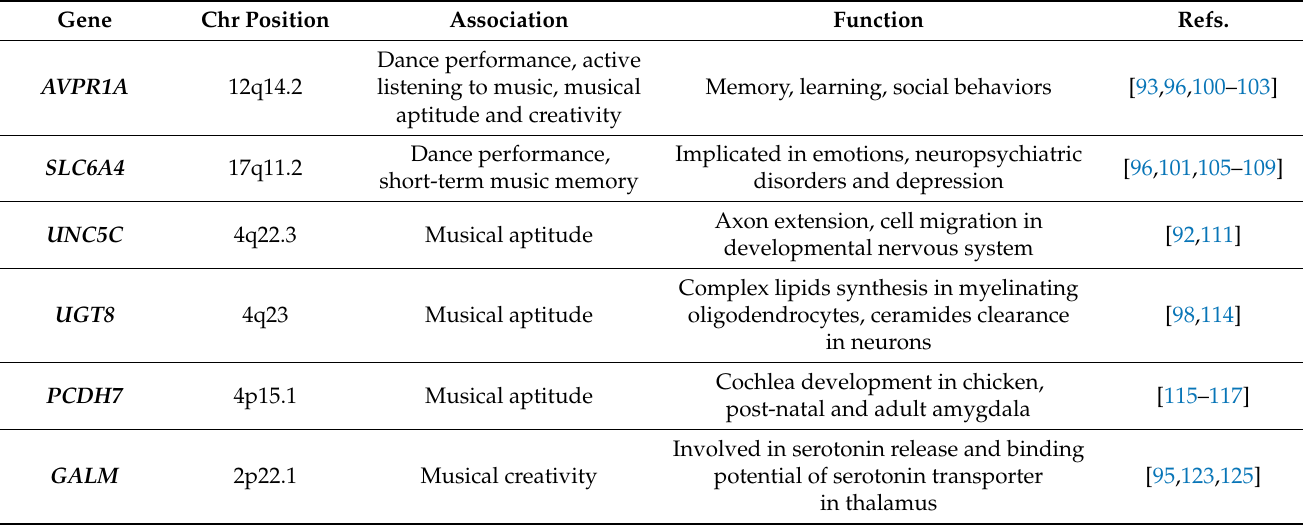
Table 1. Main candidate genes for musical